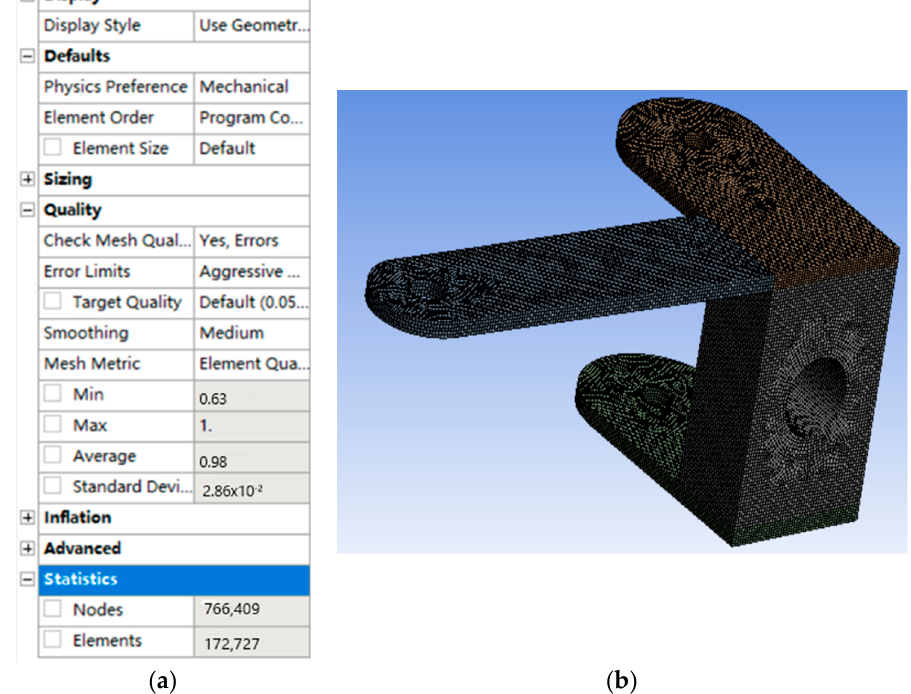
Figure 27. Mesh division and mesh quality of front wheel connector. ( a ) Element quality of the mesh, ( b ) Effect picture of meshing.